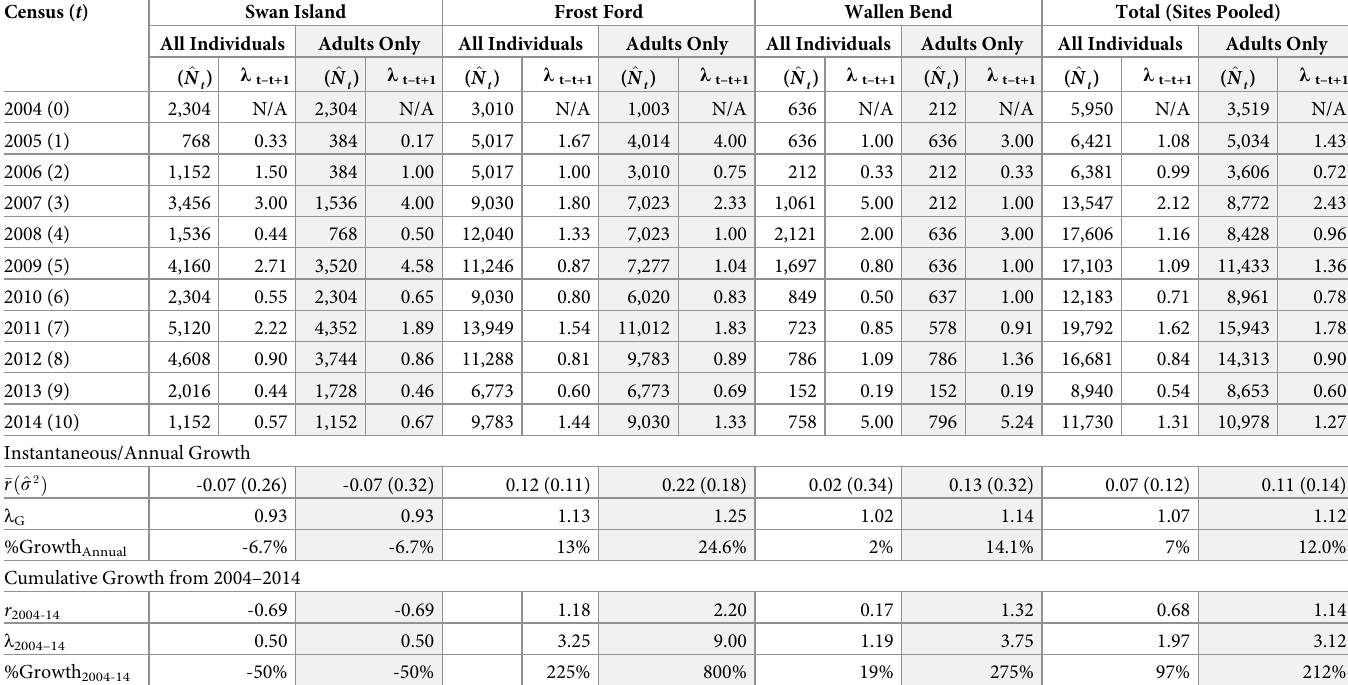
Table 3. Estimated population size per census ( ^ N ), finite rate of population increase [ λ t − t +1 ] per time step, per capita or instantaneous rate of increase [ � r ], and t cumulative population growth observed in populations of Epioblasma brevidens in the Clinch River, TN at Swan Island, Frost Ford, Wallen Bend, and Total (Sites Pooled) from